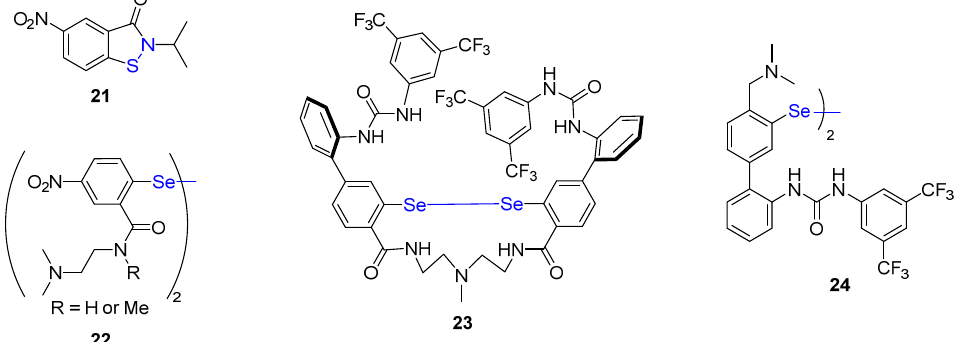
Figure 4. S ‐ N ‐ and Se ‐ Se ‐ based organocatalysts. Figure 4. S-N- and Se-Se-based